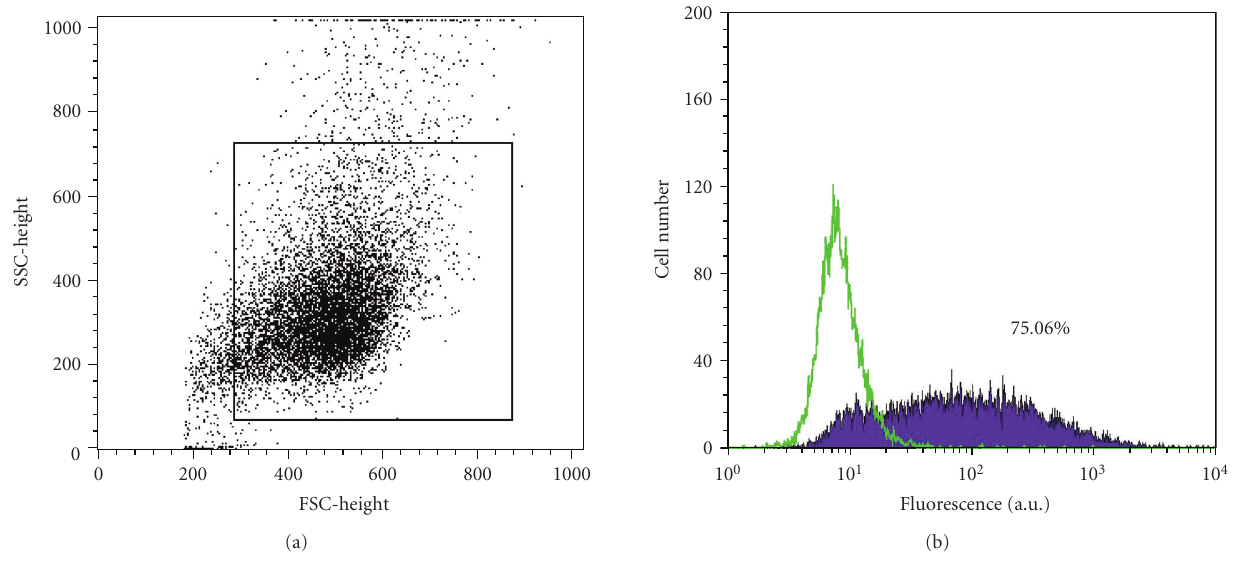
Figure 7: (a) Quantitative analysis intracellular fluorescence of HepG2 cells; (b) endocytosised with fluorescent chitosan-coated PBCA-NPs by flow cytometry.